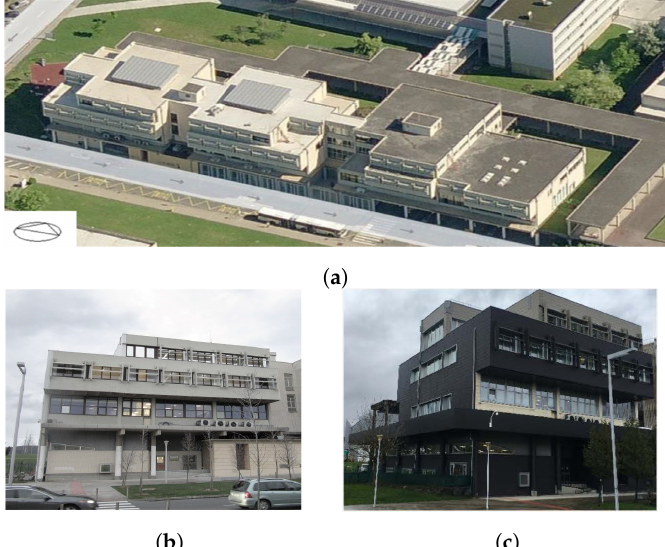
Figure 1. ( a ) View of the whole rectorate building that is formed by three blocks (west, central and east). This work focussed in the study of the retrofitting measures carried out in the west block. ( b ) West block before retrofitting. ( c ) West block after